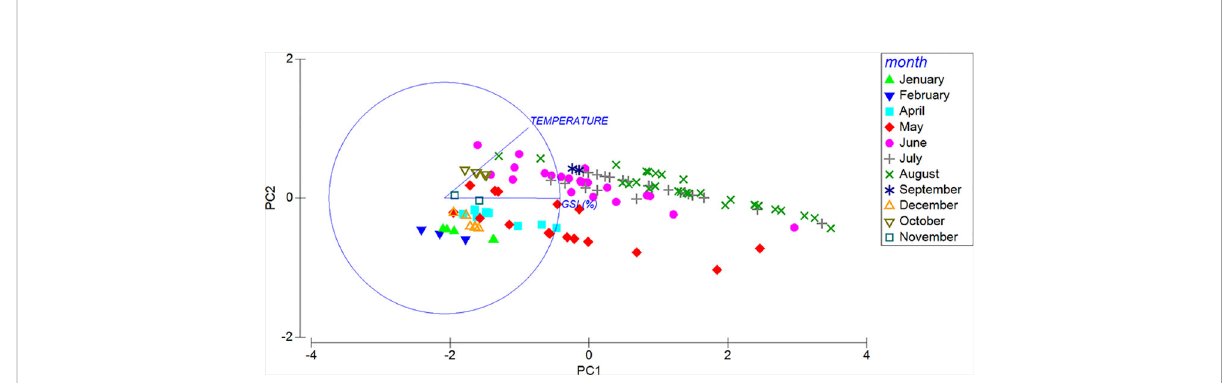
FIGURE 9 Two-dimensional PCA ordination of the pattern of GSI and temperature in different